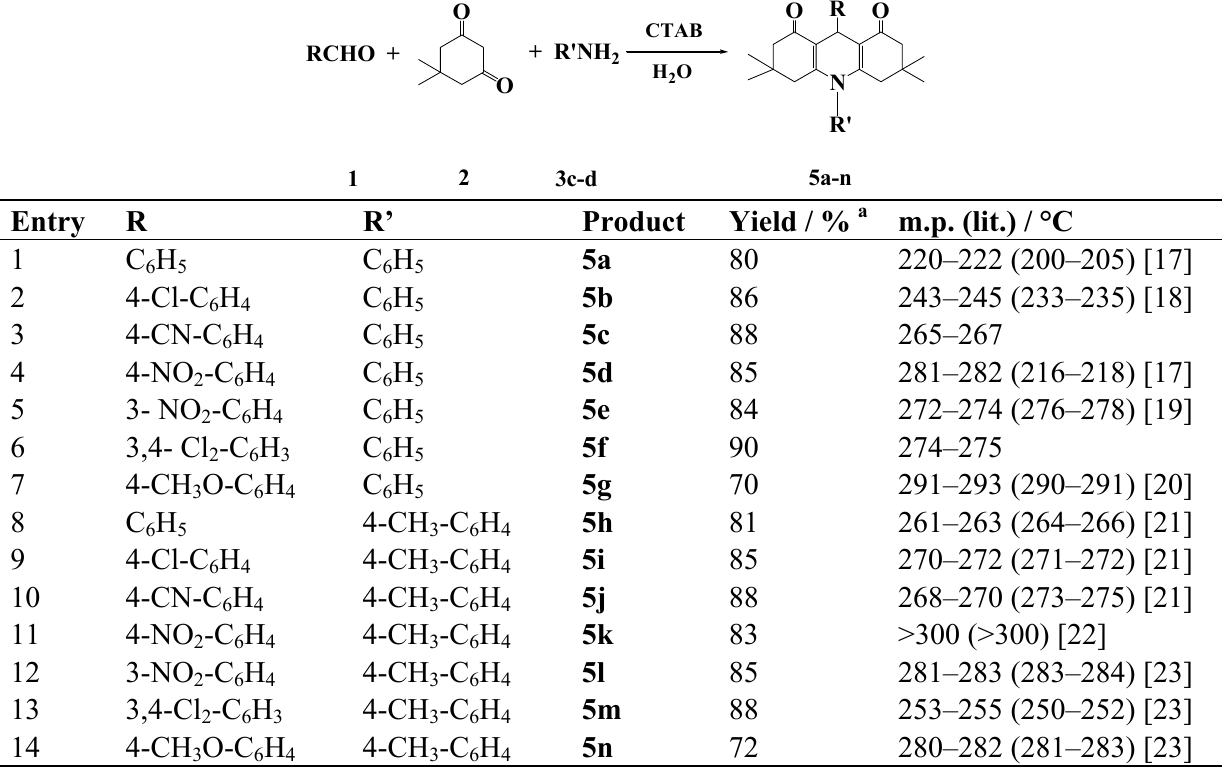
Table 2. Yields and melting points for the one-pot synthesis of N -substituted acridinediones. OO RCHO